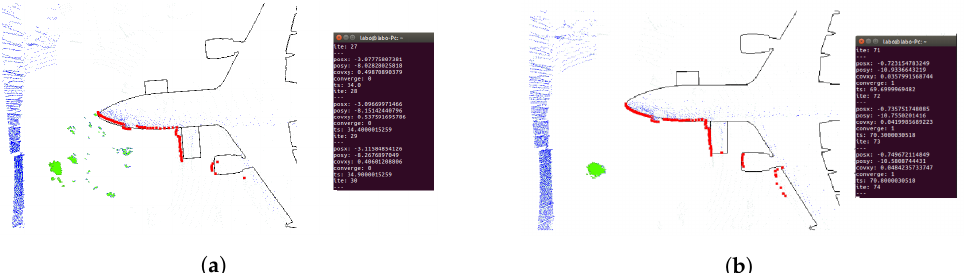
Figure 21. Convergence tests on Path 2 (Figure 16b) real flight with RANSAC PCL segmentation. Three-dimensional LIDAR point cloud (blue), 2D laser scans (red), AMCL particles (green). ( a ) UAV position before algorithm convergence. ( b ) UAV position when the algorithm converges after 71 iterations.